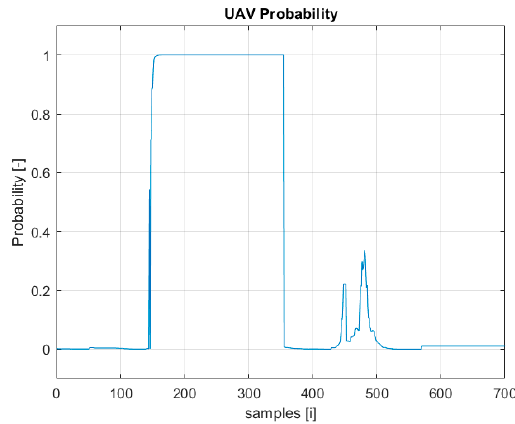
Figure 4. Probability of UAV detection plot.